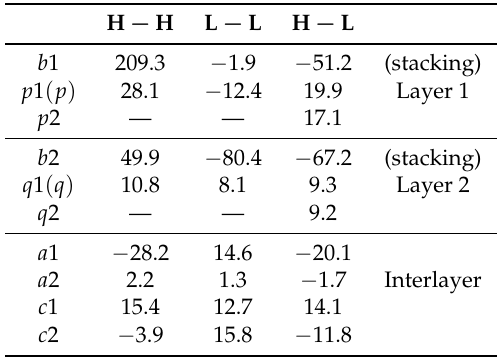
Table 1. Transfer energies for P = 5.9GPa [36] which are multiplied by 10 − 3 eV. The energy difference between the HOMO and LUMO is taken as ∆ E = 0.696